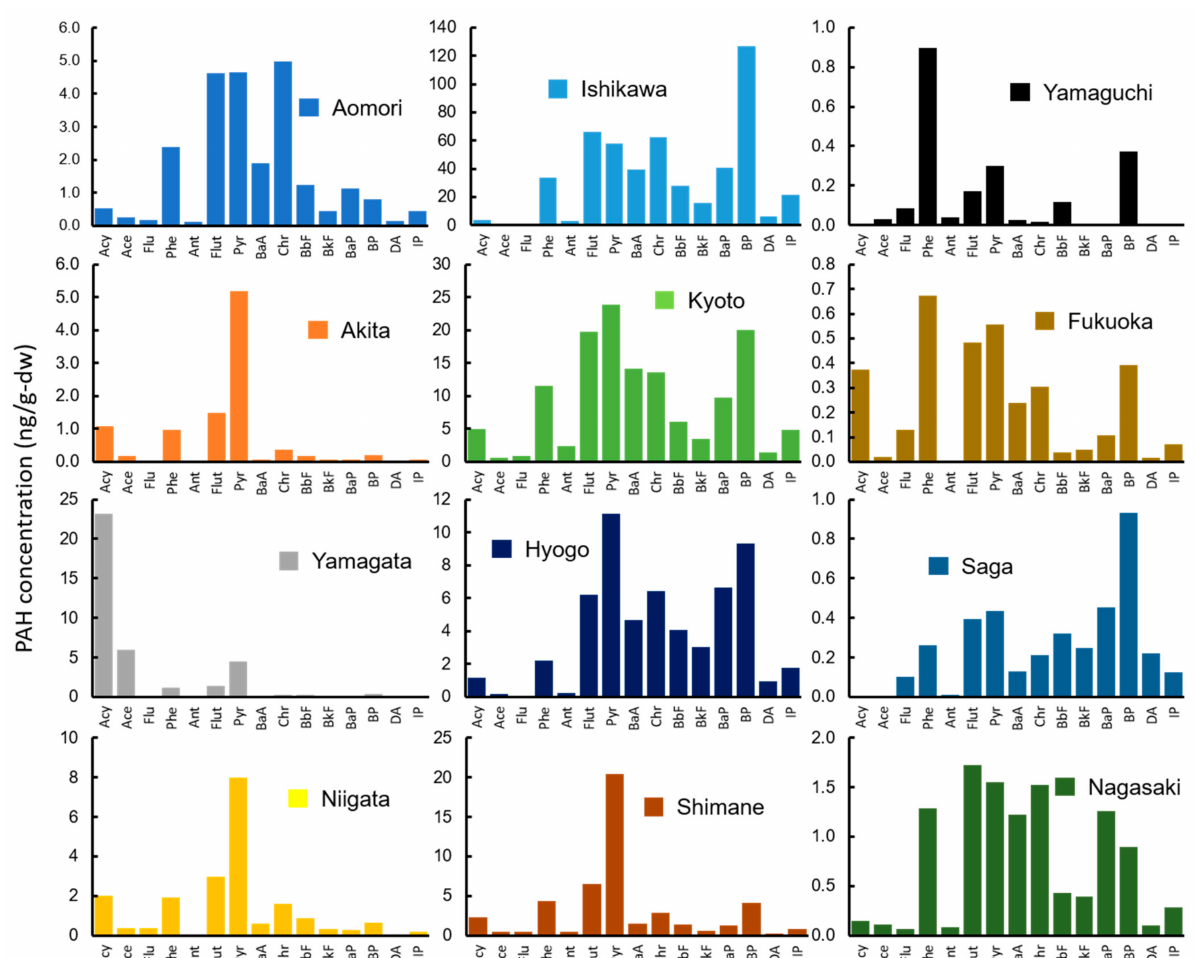
Figure 5. Concentrations of 15 PAHs in soil and sand (ng/g-dw) collected from 12 sampling